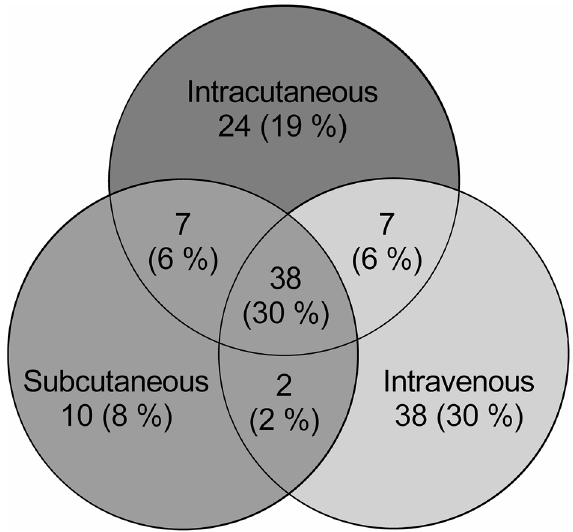
Figure 2. Three-way Venn diagram visualizing the distribution of proteins between the different tissue compartments; intracutaneous, subcutaneous and intravenous.